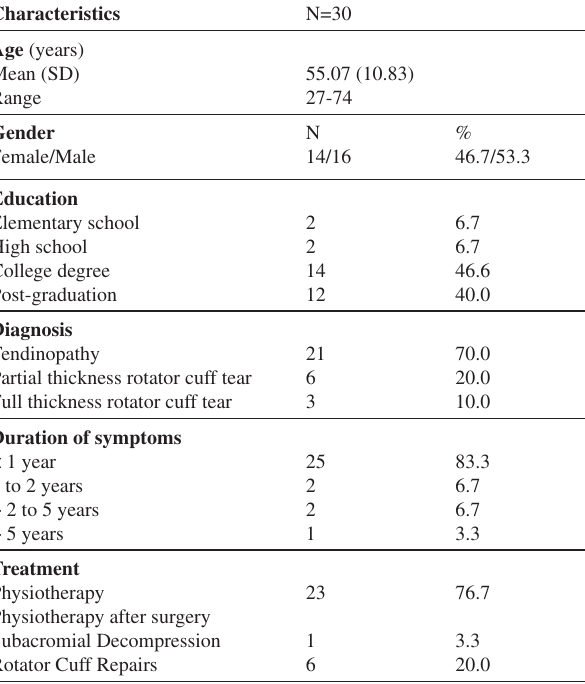
Table 1 - Baseline Characteristics